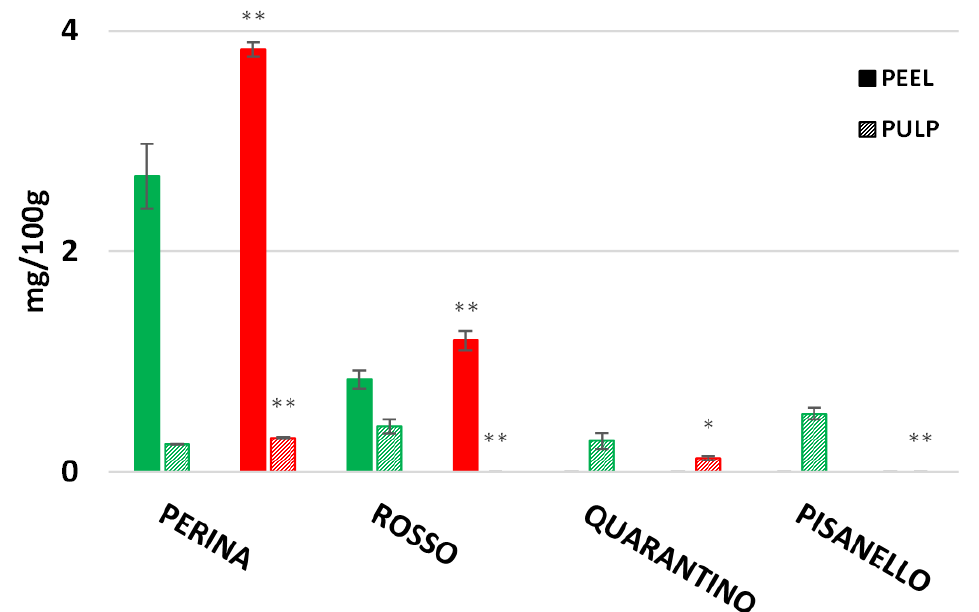
Figure 14. Caffeic acid content in 4 Italian tomato cultivars. The concentration of peel in full color and pulp in stripes color. CTRL indicates the control group of tomato and DS the drought-stressed group. The bars indicate the standard deviation. A significant difference is shown between CTRL and DS of each cultivar by * for a p ≤ 0.05 and ** for p ≤ 0.01.